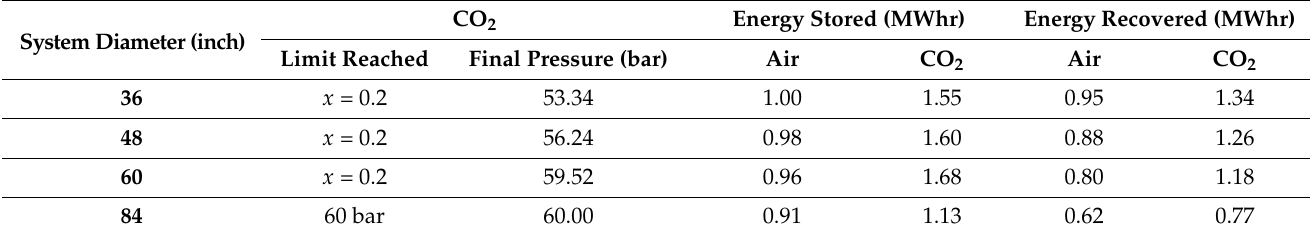
Table 6. Limit reached and final pressure of the CO 2 after the charging stage along with the energy stored and recovered for both air and CO 2 .